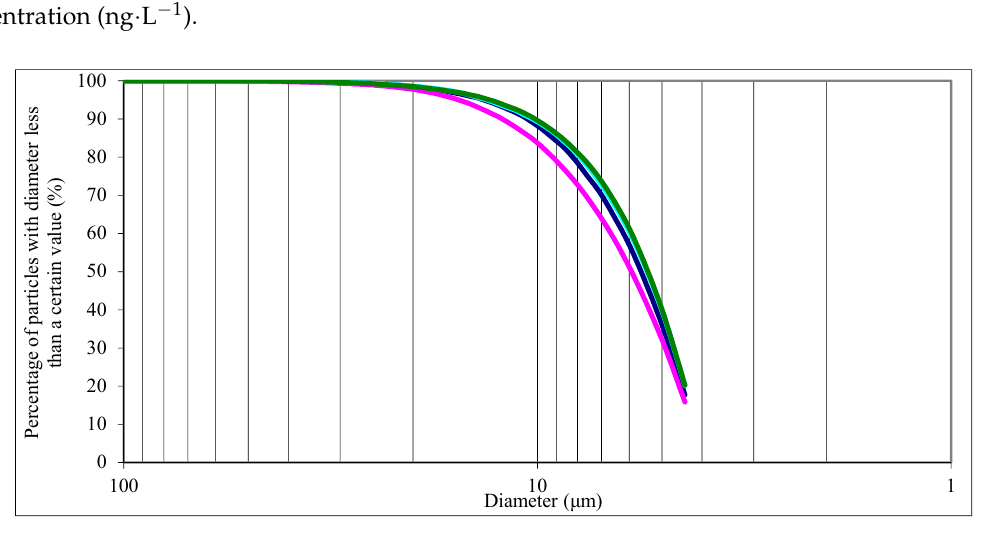
Figure 13. Solids grading curves for the watercourse of Xiaxi River